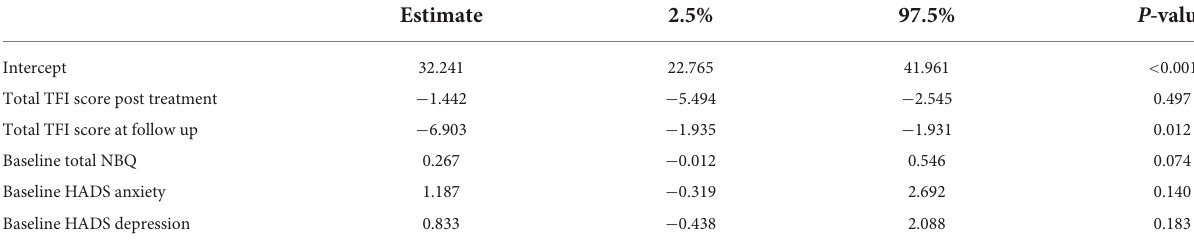
TABLE 2 Mixed effect linear regression model explaining the change in the TFI questionnaire